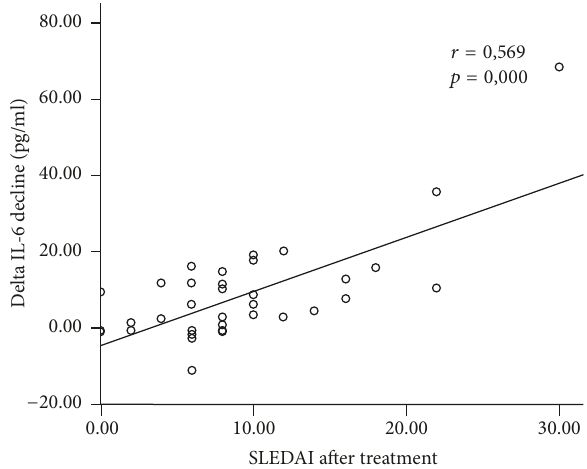
Figure 3: Correlation between SLEDAI and decline of IL-6 serum after